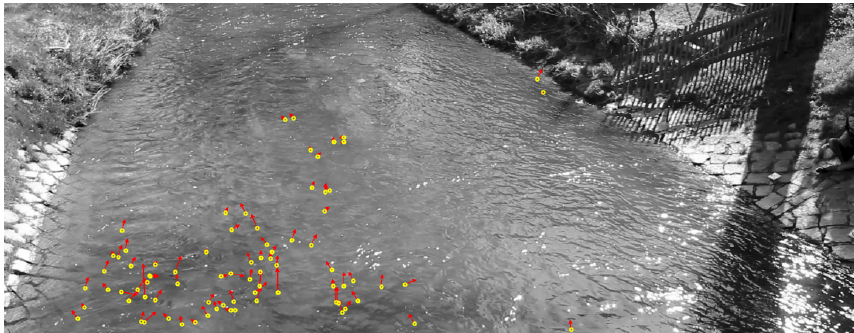
Figure 4. Exemplary display of the tracking result from one frame to the next.